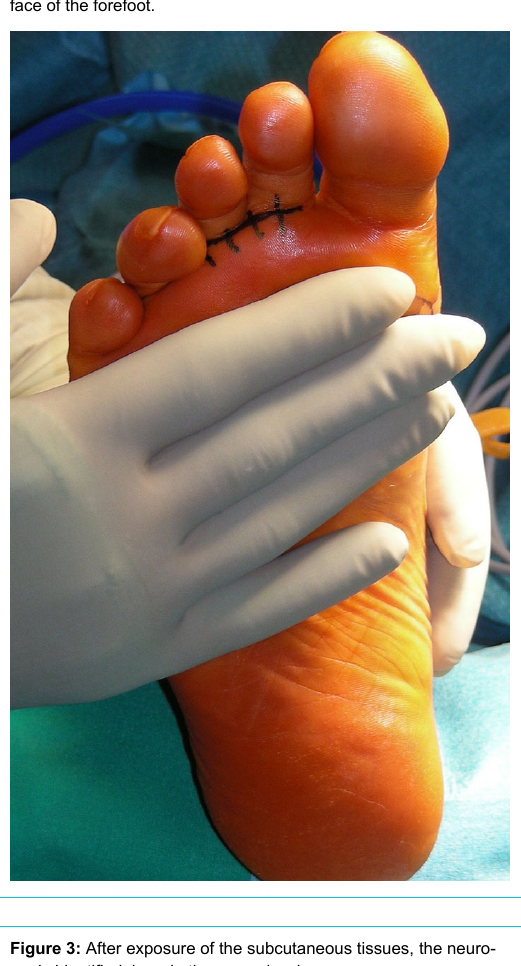
Figure 2: Plantar pressure is applied to the forefoot in order to ex- clude any overlap between the incision and the weight bearing sur- face of the forefoot.